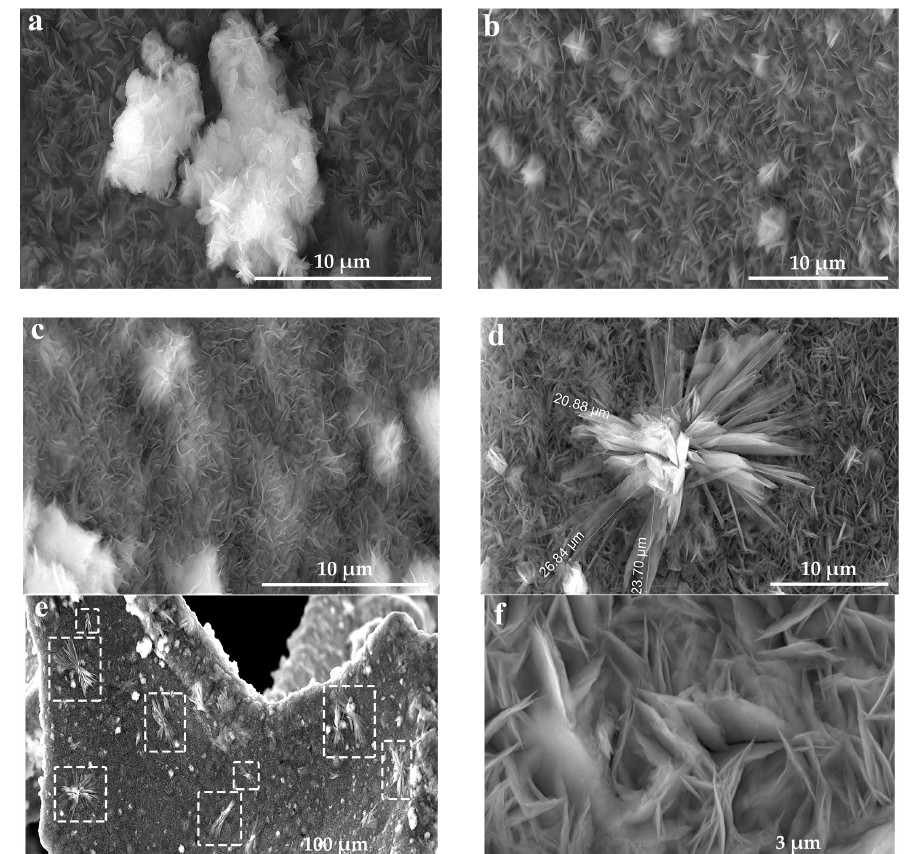
Figure 5. SEM images of the samples: ( a ) Ni(OH) 2 -pure; ( b ) Ni(OH) 2 -PVP; ( c ) Ni(OH) 2 -PVP-Co- elchem; ( d – f ) Ni(OH) 2 -PVP-Co-chem. elchem; ( d – f ) Ni(OH) 2